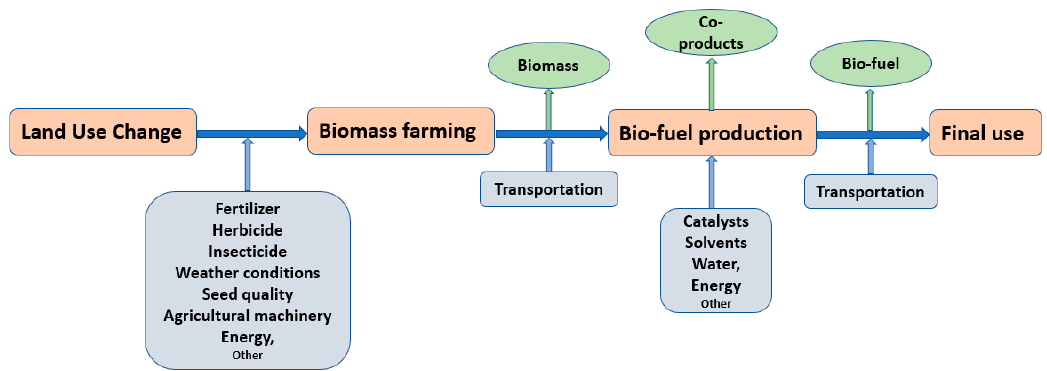
Figure 1. Simplified life cycle analysis (LCA) scheme.